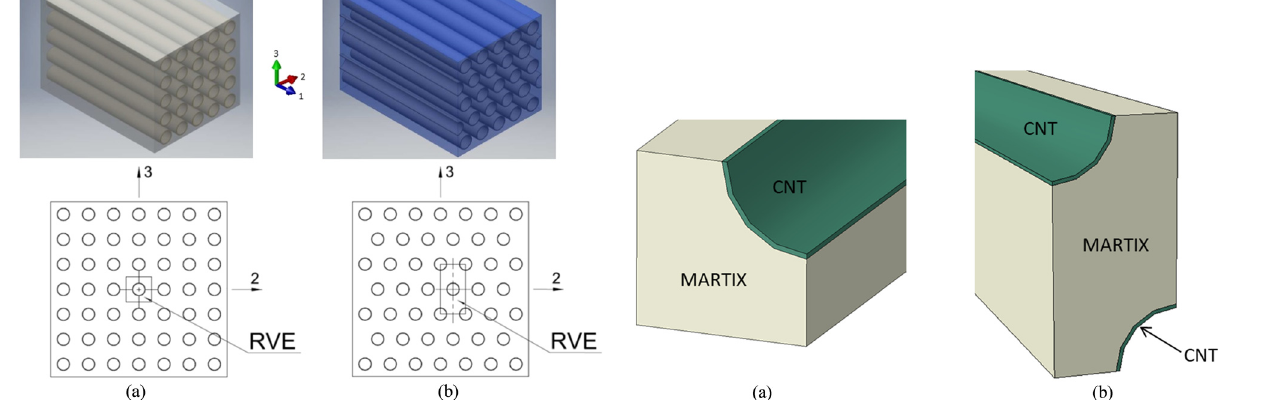
Figure 2: Magnification of the cylindrical CNT embedded in the one - fourth RVE for 2.75% vol of CNTs for ( a ) square and ( b ) hexagonal